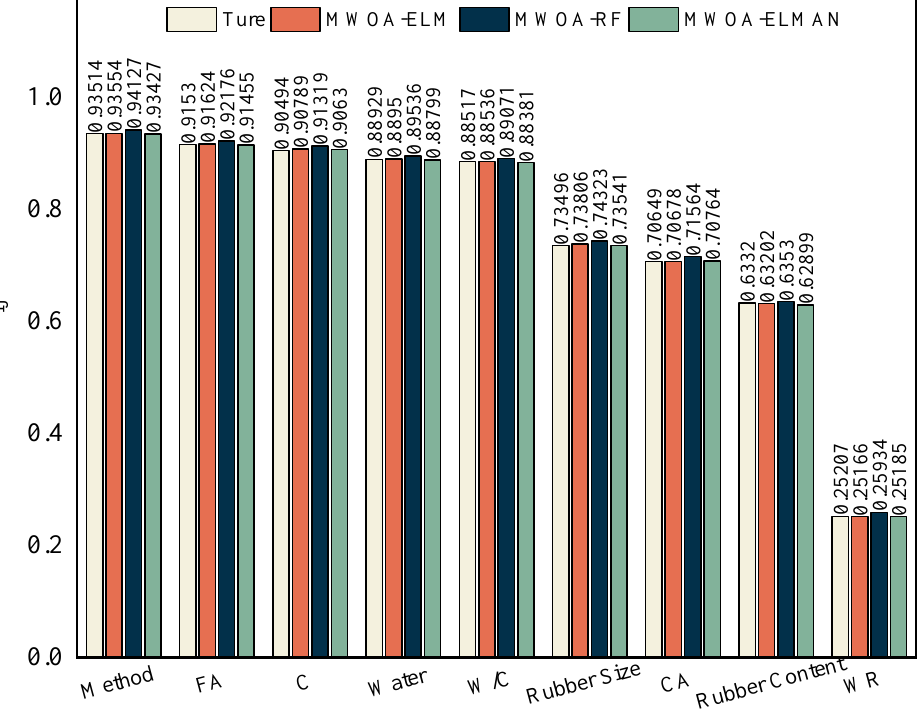
Figure 14. Sensitivity analysis of three models and experimental models.